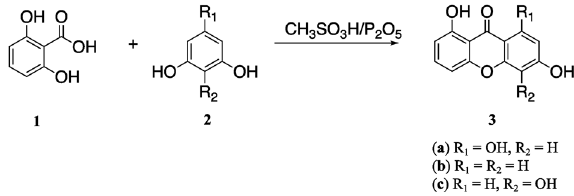
Figure 1. Synthesis scheme of hydroxyxanthone